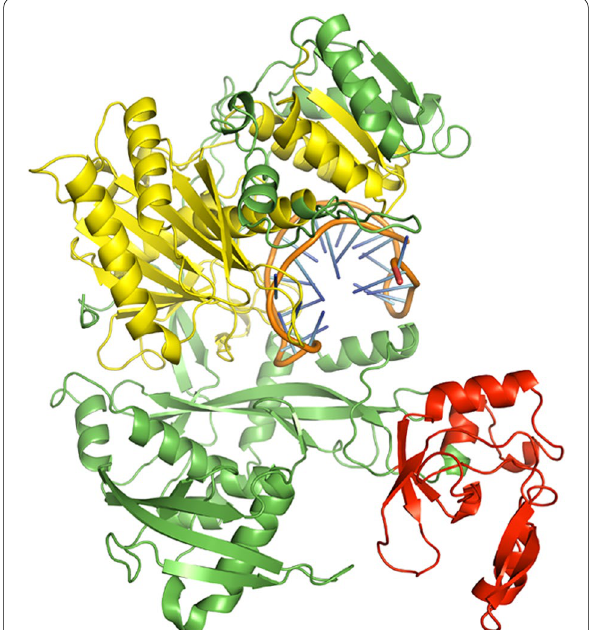
Fig. 7 A docked complex of AGO2 and S28.5. RNA, PAZ, PIWI, and the remaining regions are represented in orange, red, yellow, and green colors, respectively